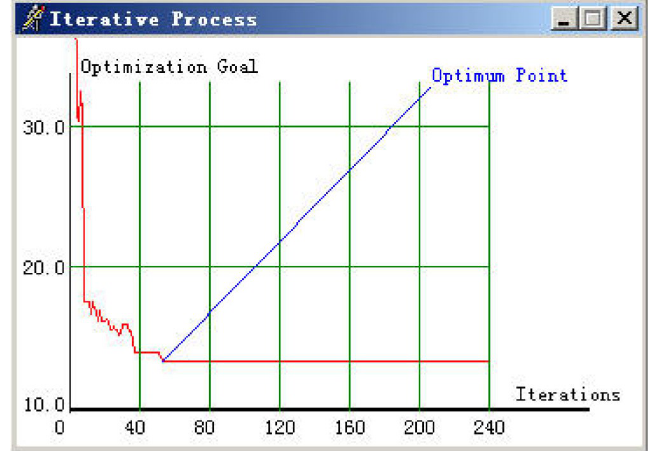
Figure 5. Fitness curve of every solution in each